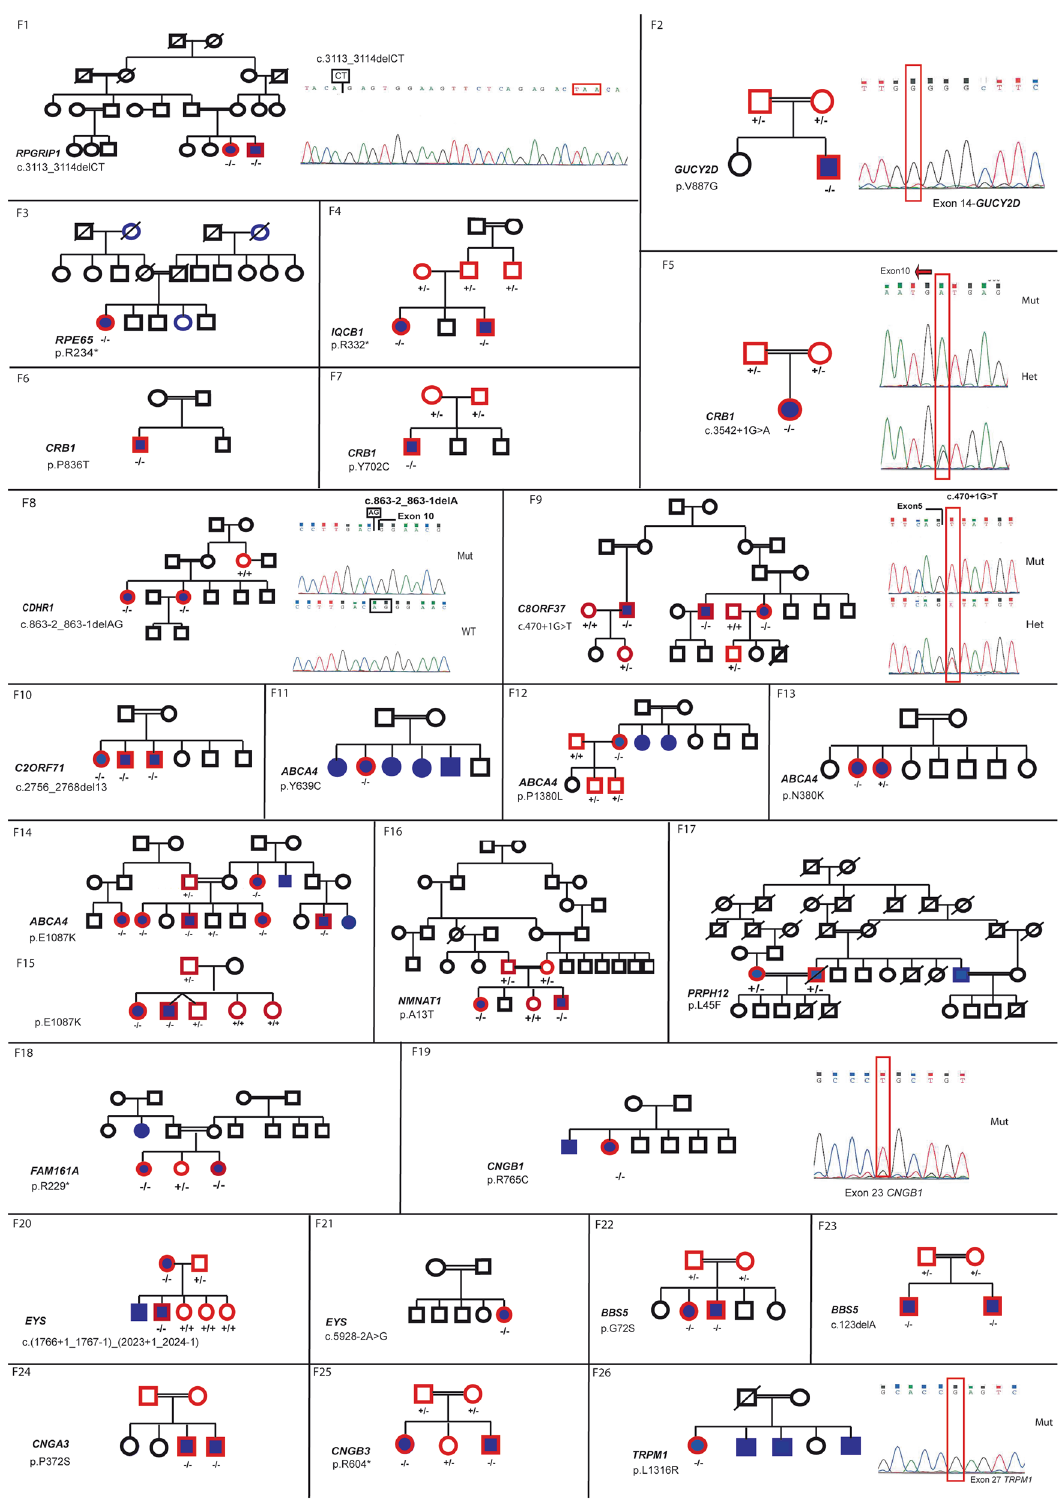
Figure 2. Segregation analysis of disease causing variants in the families with IRD. Affected individuals are indicated with filled symbols (blue), whereas unaffected relatives are indicated by open symbols. +: wild type allele; −: pathogenic